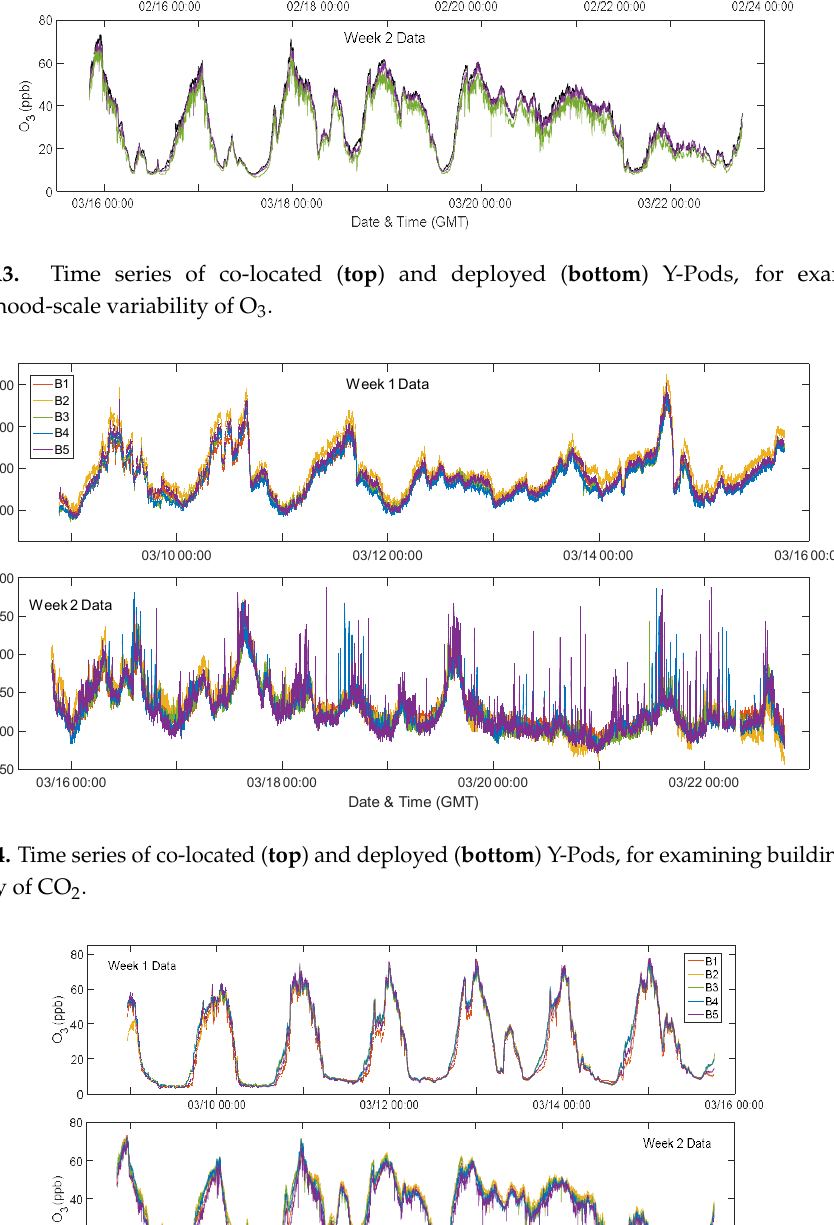
Figure A5. Time series of co-located ( top ) and deployed ( bottom ) Y-Pods, for examining building-scale variability of O 3 .